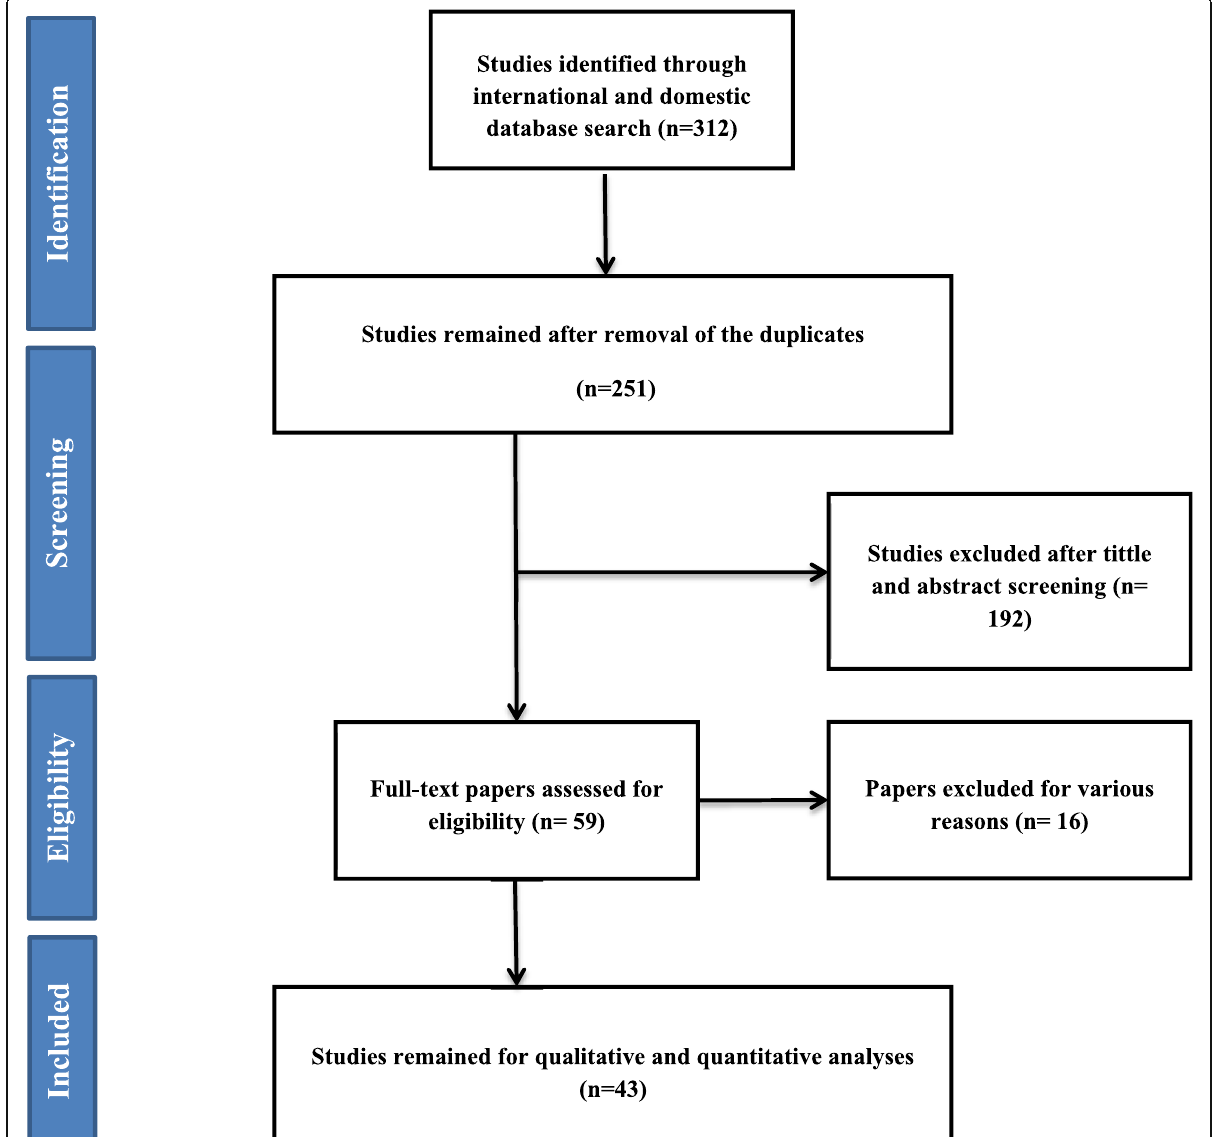
Fig. 1 Flowchart of the included eligible studies in the systematic